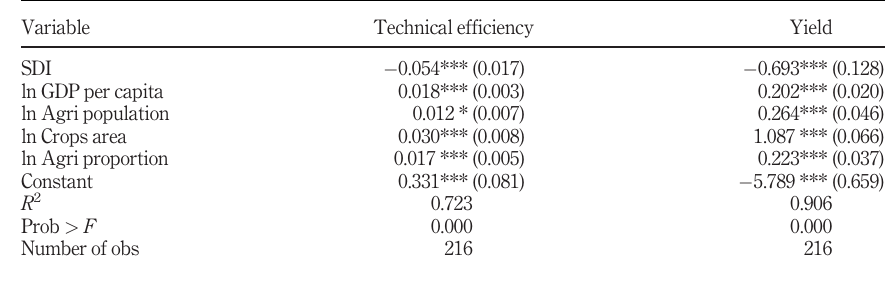
Table 4. Impact of farmers ’ cropping strategy on economic